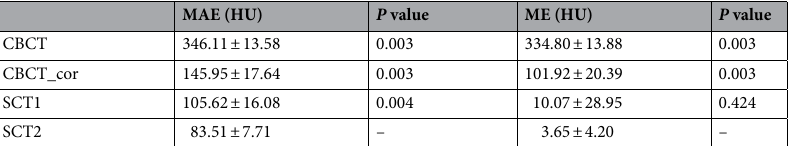
Table 1. MAE and ME results for four kinds of images against RCT images from all validation cases. MAE mean absolute error, ME mean